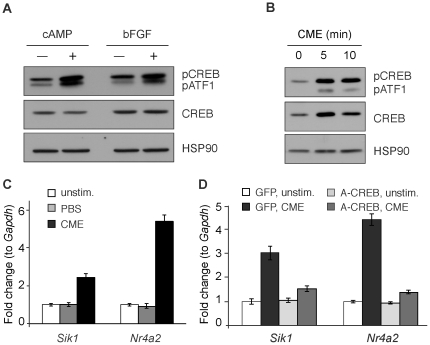
CREB is activated by crushed muscle extract in primary myoblasts.A) Phospho-CREB (pCREBS133), pATF1, total CREB and HSP90 in primary skeletal myoblasts treated with FSK/IBMX (cAMP) or bFGF for 10 min. B) pCREB, total CREB and HSP90 in primary skeletal myoblasts treated with crushed muscle extract (CME) for 0, 5 and 10 min. C) Amounts of Sik1 and Nr4a2 mRNA in primary skeletal myoblasts left untreated or incubated 1 h with PBS or CME. D) A-CREB expression in primary skeletal myoblasts blocks Sik1 and Nr4a2 induction by CME (1 h). In C and D, mRNA is normalized to Gapdh, represented as fold change above unstimulated (± stdev). Representative of 3 experiments. For D, treatments were normalized to GFP, unstimulated for each target gene.